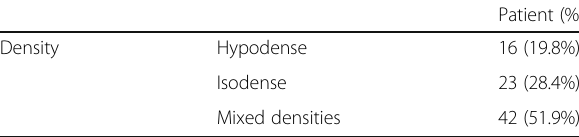
Table 2 Frequencies of different hematomas ’